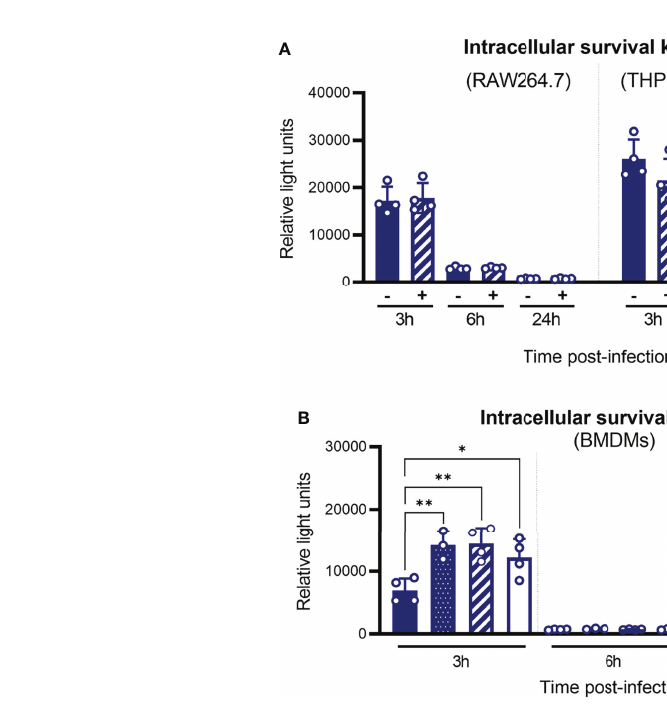
FIGURE 5 | Disappearance of leptospires between 3 and 6 hpi is not TLR-mediated. (A) Intracellular survival 3, 6, and 24 h post-infection of L. interrogans serovar Manilae strain MFLum1 in RAW264.7 stimulated with 1 µg/ml LPS of E coli and infected during 1 h with subsequent gentamicin protection assay. Intracellular survival was directly assessed by luminescence measurement on cell lysates diluted in EMJH. (B) Intracellular survival 3, 6, and 24 h post-infection of L. interrogans serovar Manilae strain MFLum1 in WT, TLR2 ko, TLR4 ko, and MyD88/TRIF dko BMDMs infected during 1 h with subsequent gentamicin protection assay. Intracellular survival was directly assessed by luminescence measurement on cell lysates diluted in EMJH. (A, B) Bars correspond to mean +/- SD of technical replicates ( n >3). Data presented are representative of at least two independent